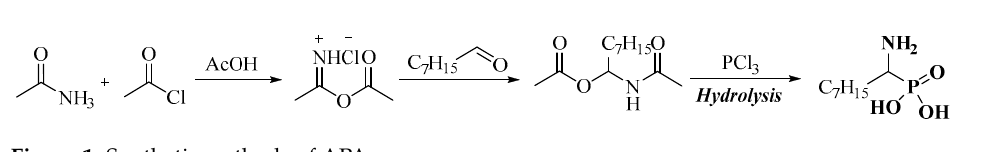
Figure 1. Synthetic methods of APA. Table 2. Chemical composition of ilmenite sample.